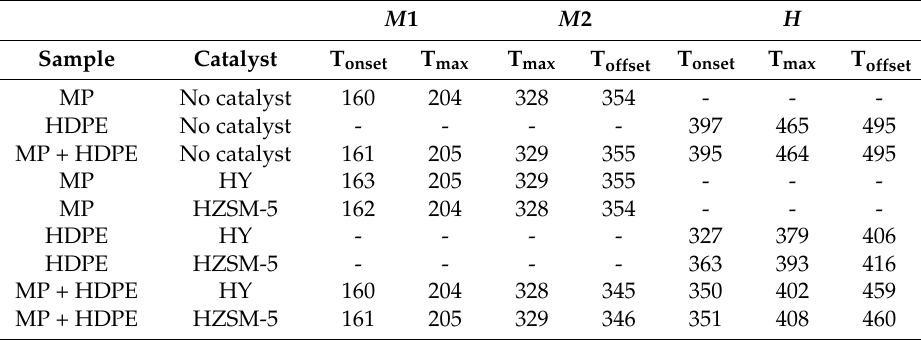
Table 1. Thermal and catalytic degradation temperature properties of MP, HDPE, and their mixture at